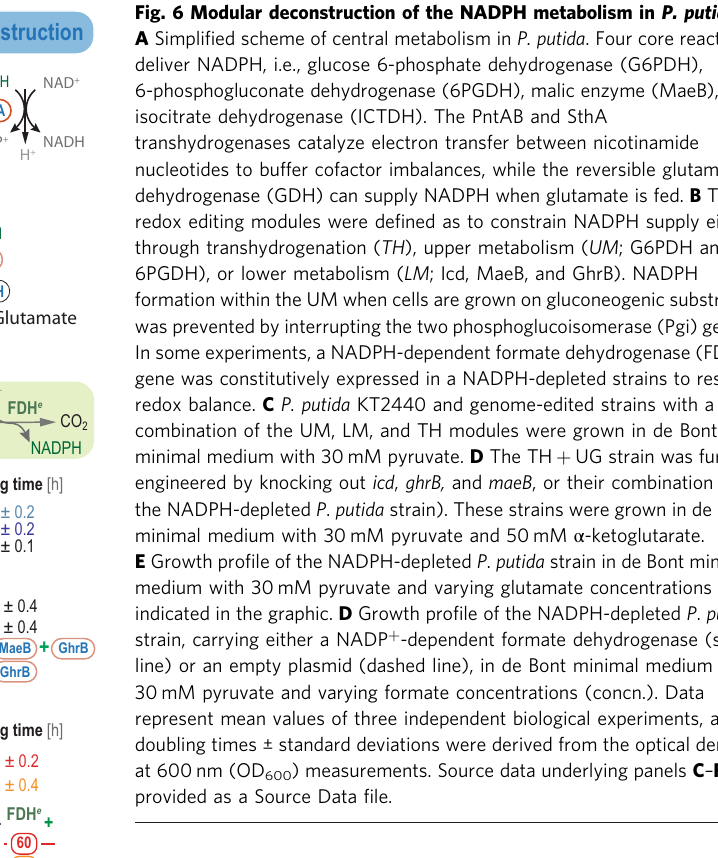
line) or an empty plasmid (dashed line), in de Bont minimal medium with 30 mM pyruvate and varying formate concentrations (concn.). Data represent mean values of three independent biological experiments, and doubling times ± standard deviations were derived from the optical density at 600 nm (OD 600 ) measurements. Source data underlying panels C – F are provided as a Source Data fi